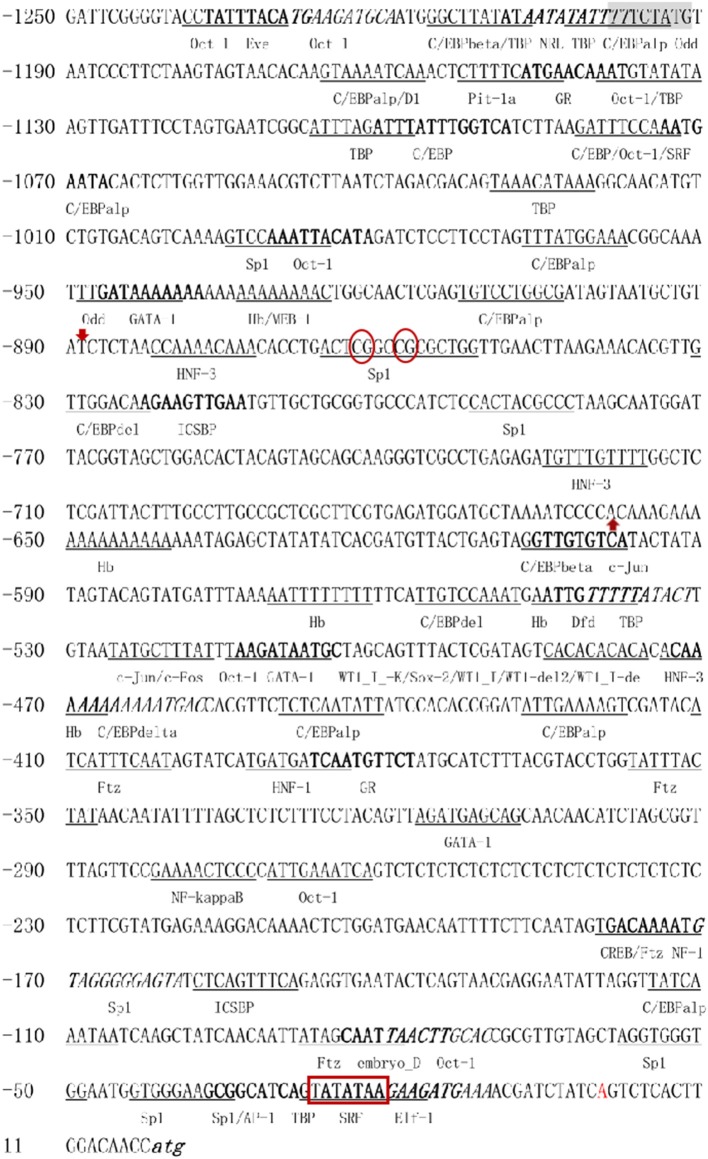
The 5′-flanking region and putative cis-acting elements. The deduced transcriptional start site (A) is marked by red and defined as position 1. The nucleotide sequence is numbered on the left. The TATA box is marked in bold with red border. The putative transcription factor binding sites are marked by underlined, bold, or italic. Red arrows mark the beginning and end of CpG island, CpG-1 and CpG-2 are marked in red oval.